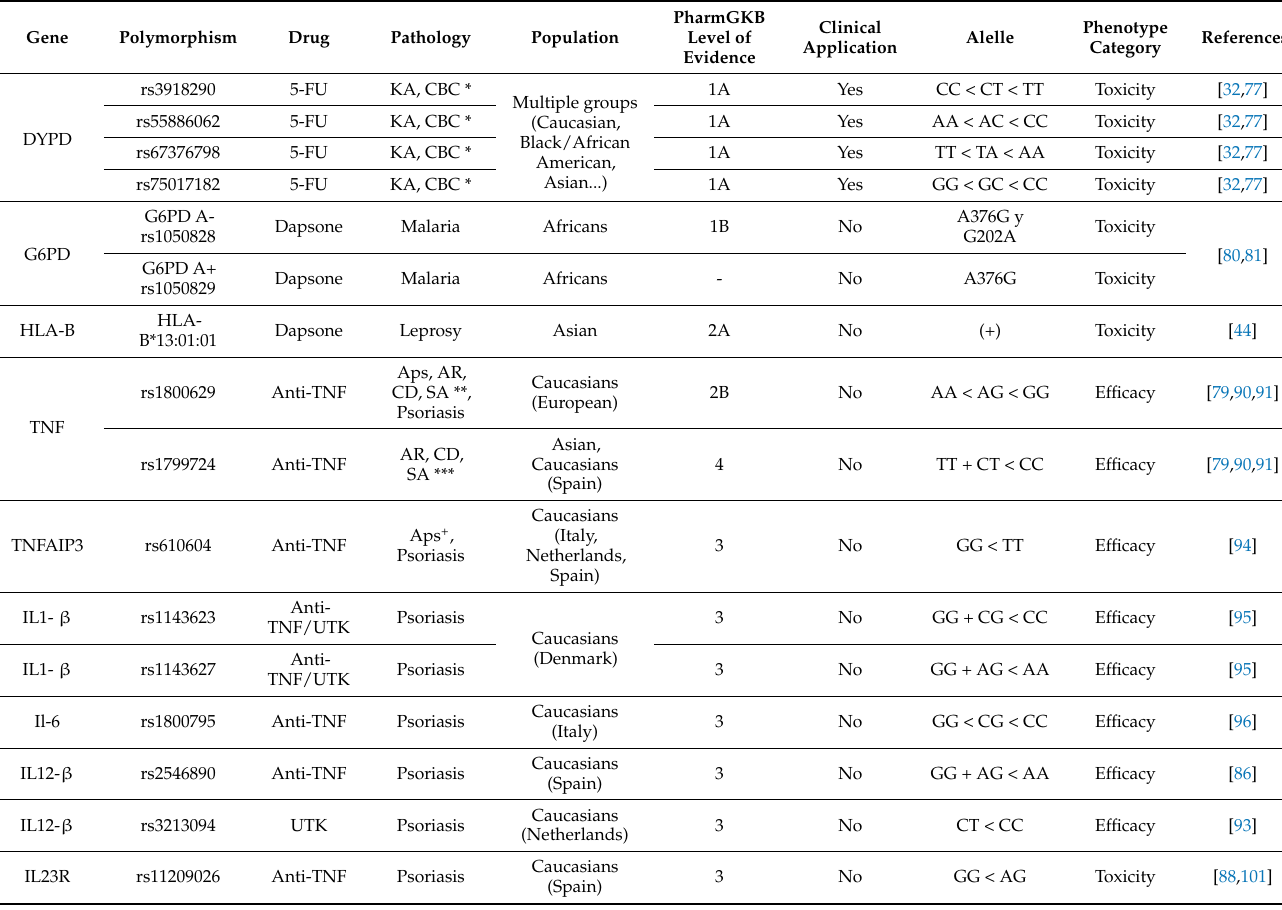
Table 1. Gene polymorphisms involved in response or toxicity to dermatological treatment by PharmGKB. Gene Polymorphism